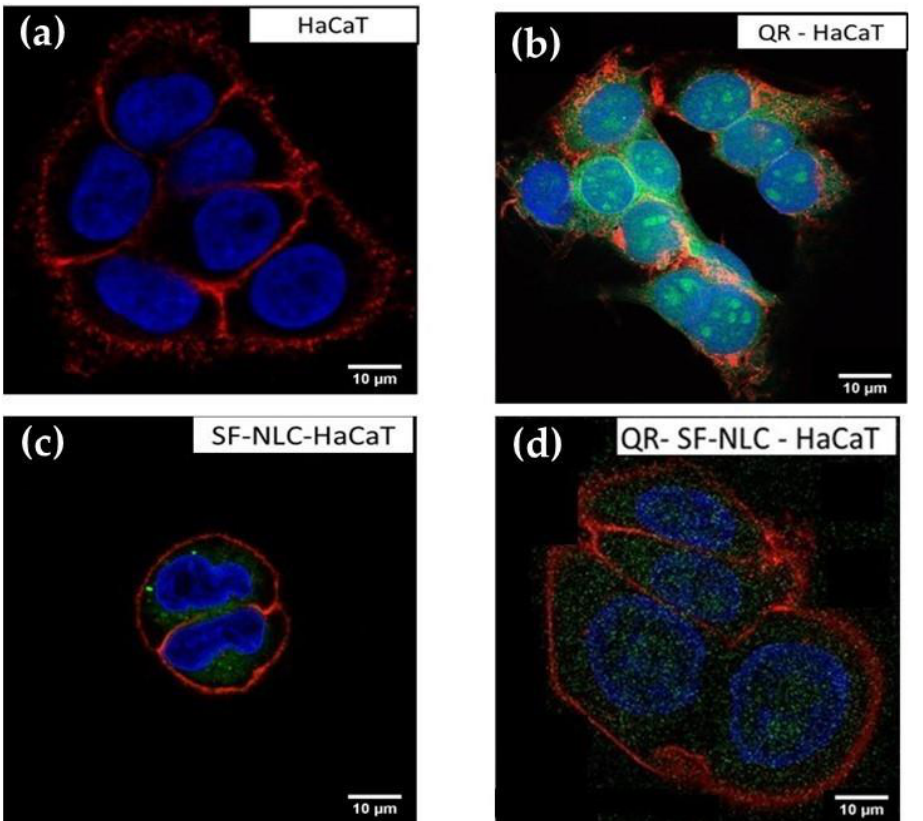
Figure 9. Cellular internalization of SF-based NLCs at dilution D = 50 after 3 h incubation. ( a ) HaCaT cells with non-labeled lipid nanoparticles; ( b ) QR (2.5 mg/mL in propylene glycol) with HaCaT cells; ( c ) SF-NLC-DiO with HaCaT cells; ( d ) QR-SF-NLC with HaCaT cells (0.5% QR); cell membranes labeled with WGA-Alexa 594 (red) and nuclei stained with DAPI (blue).